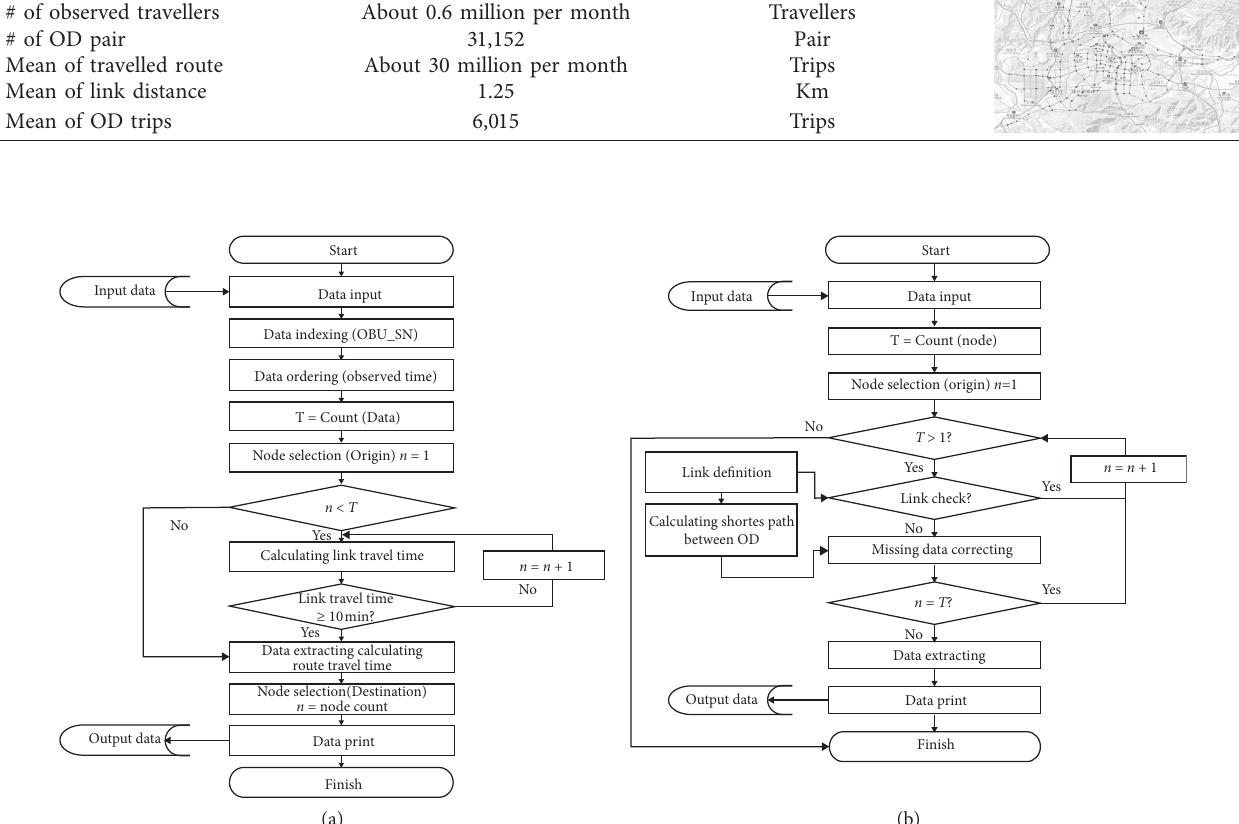
Figure 4: Data processing and correction: (a) algorithm for route data processing; (b) algorithm for the correction of missing